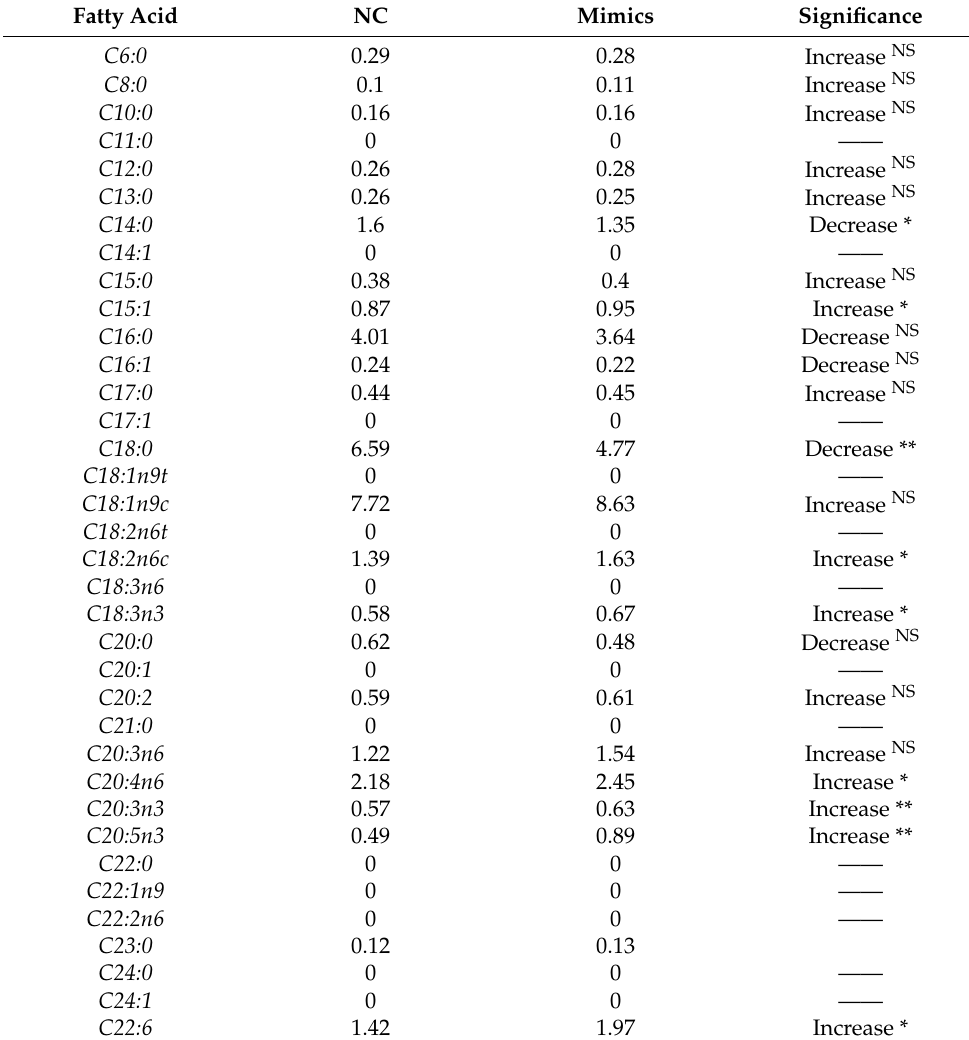
Table 1. miR-370-3p regulates fatty acid composition in